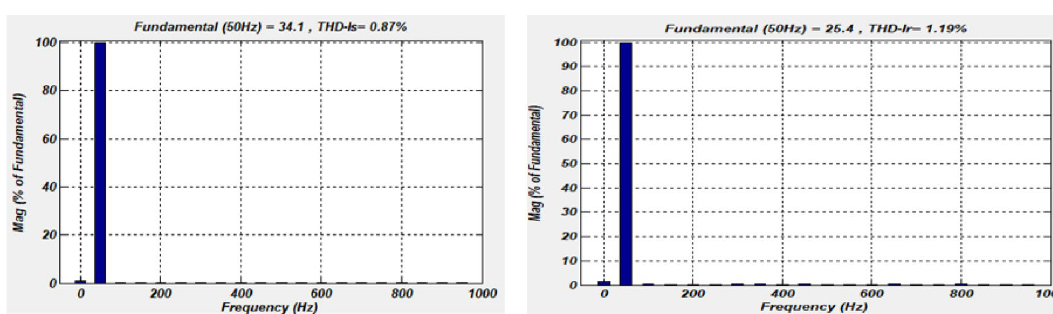
Figure 9. Spectral analysis of the phase current Isa and Ira using the Sliding-Backstepping Mode